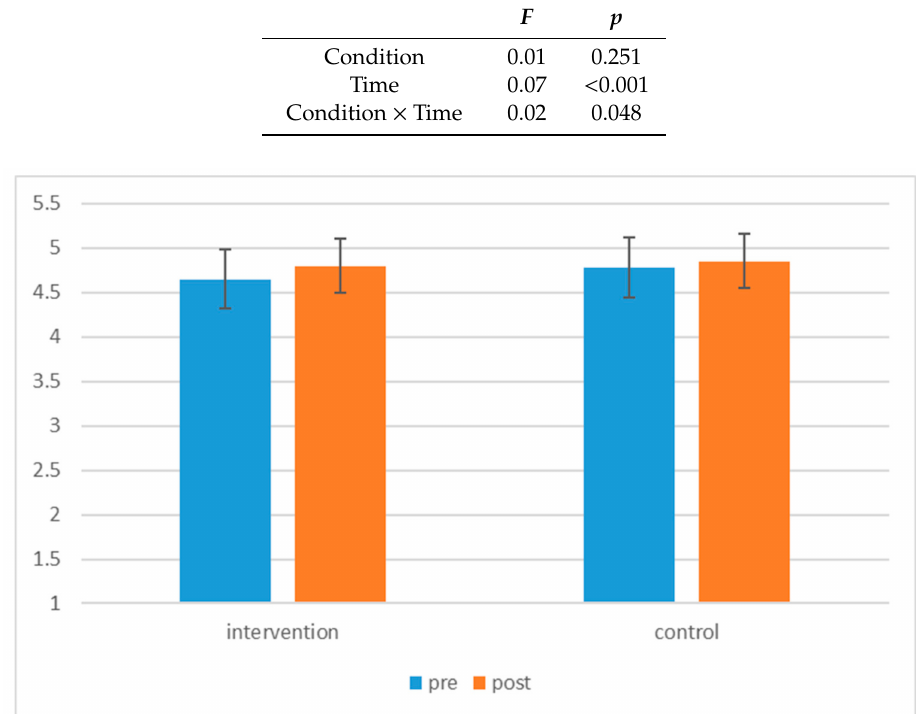
Figure 1. Significant intervention e ff ect (pre- and post- overall multiculturalism scores by